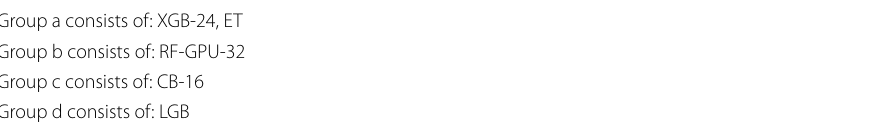
Table 14 HSD test groupings after ANOVA of AUC for the size factor Group a consists of: Medium Group b consists of: Small Group c consists of: Large